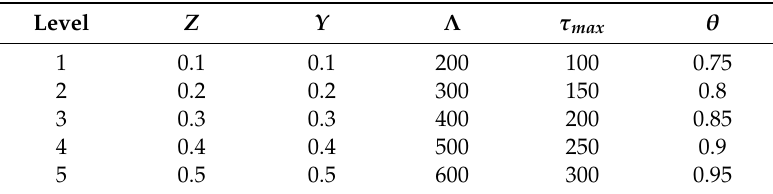
Figure A1. The main effect graph of HDDE. Table A1. HDDE algorithm parameters level.